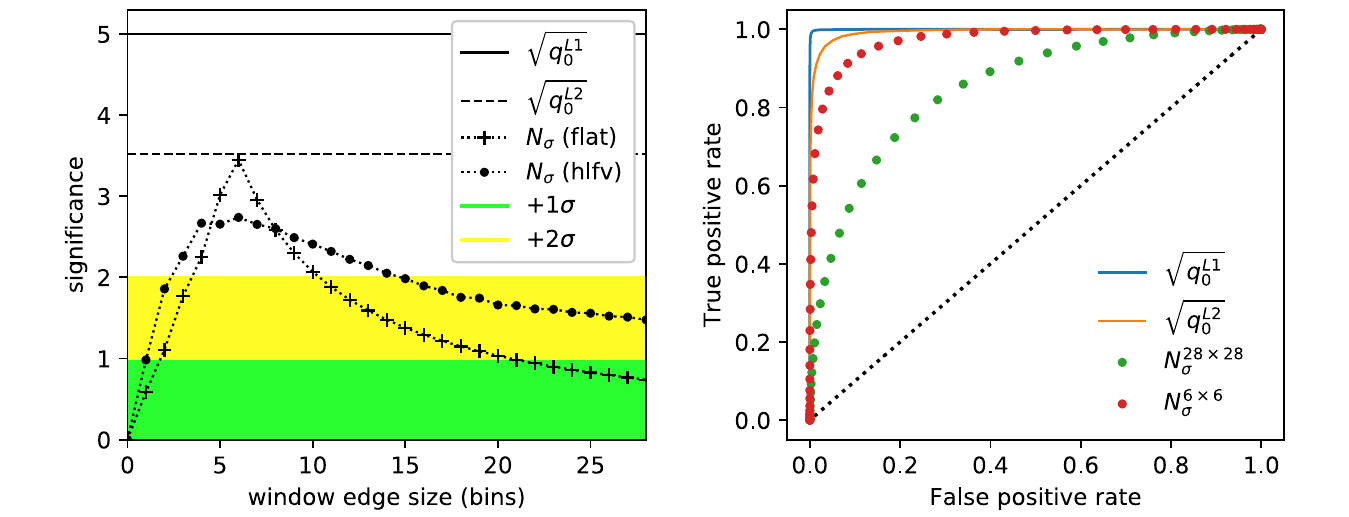
and q L 2 tests for 0 0